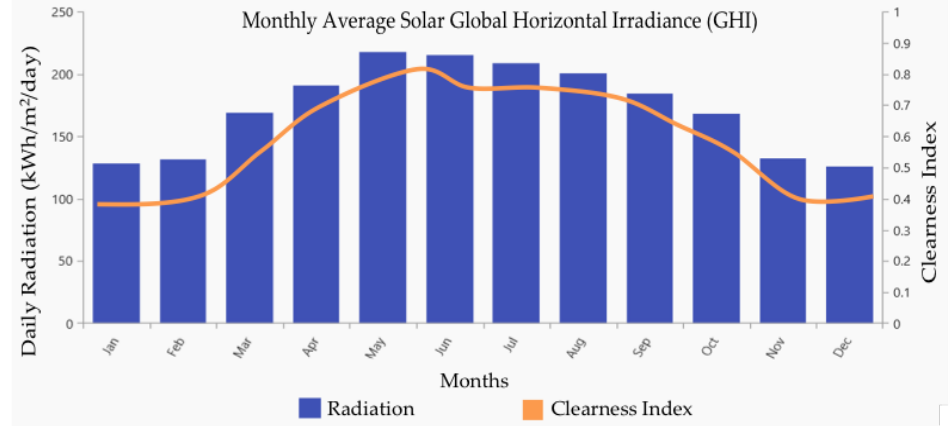
Figure 4. Monthly Average GHI and Clearness Index Dubai.